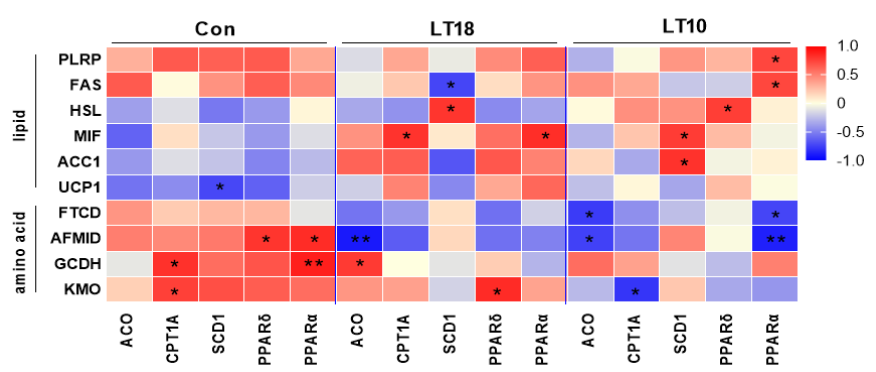
Figure 7. The metabolism of lipid and amino acid were co-related with PPARs signaling under hy- pothermia in freshwater drum. Asterisk represents the statistical difference (*, p <0.05; **, p < 0.01).